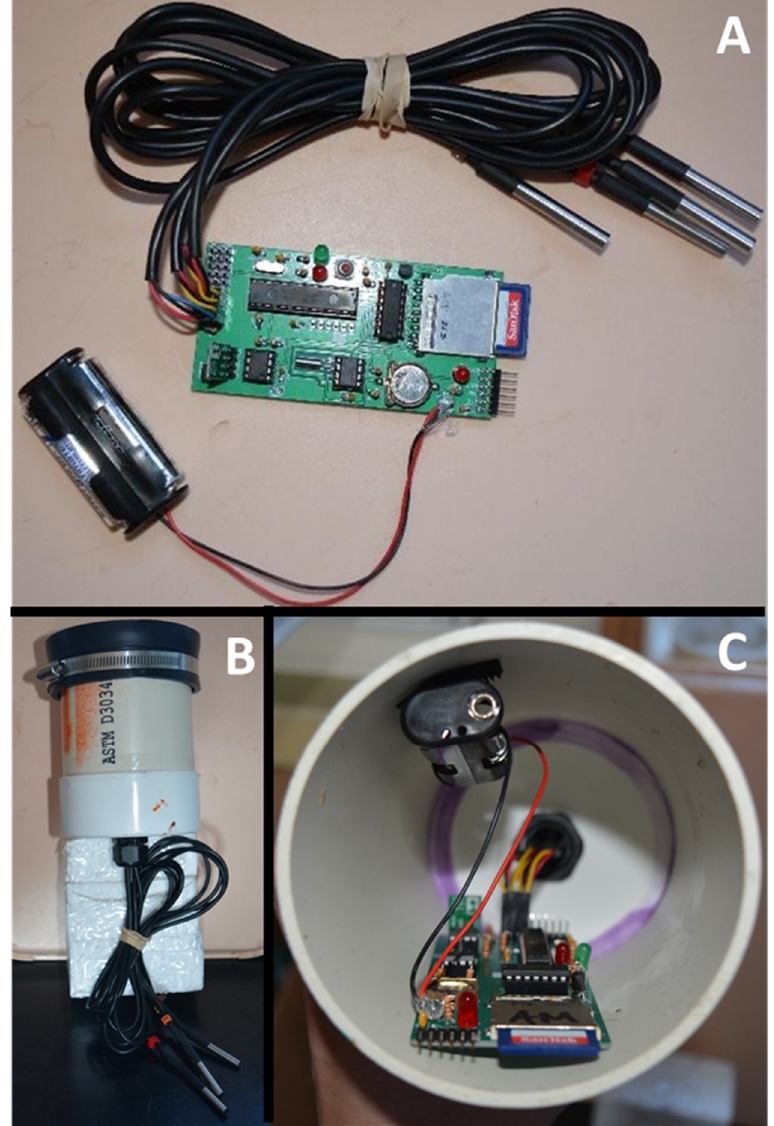
Figure 1. ( A ) A fully assembled do-it-yourself (DIY) soil temperature data logger with four external temperature sensors. ( B ) External view of a DIY soil temperature data logger in an enclosure made from PVC pipe. ( C ) Internal view of a DIY soil temperature data logger mounted in an enclosure made from PVC pipe.